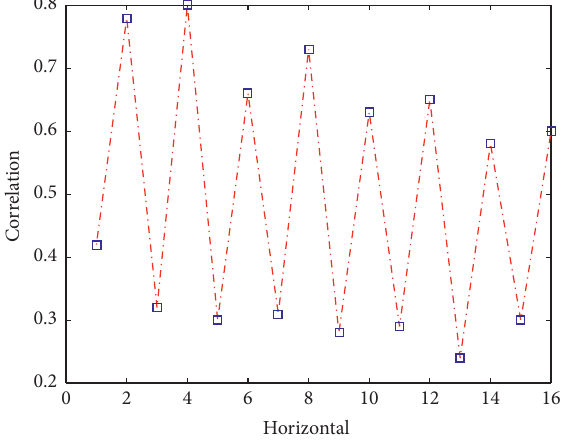
Figure 10: Correlation values of the structure as a function of the transverse offset.